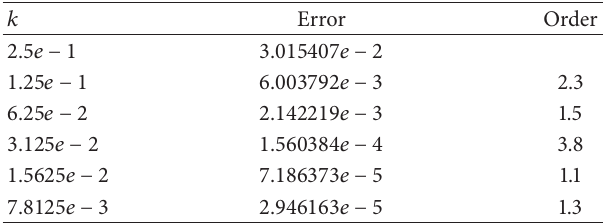
Again, we consider that 𝑏(𝑥) vanishes out of the interval [1/4, 1] . Coefficient 𝑏 1 is chosen in order to ensure that the maximum value of 𝑏(𝑥) is 1 . Note that, now, this extended function is discontinuous.